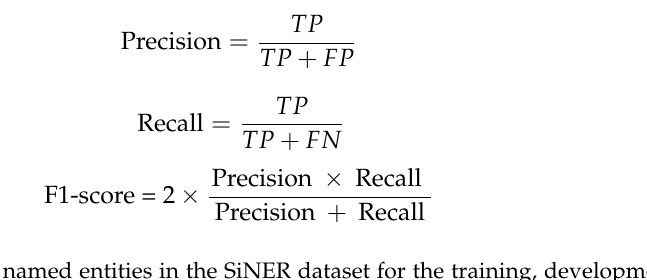
Table 2. The statistics of named entities in the SiNER dataset for the training, development, and test sets. The highest proportion named entities is Person names, followed by miscellaneous and geopolitical